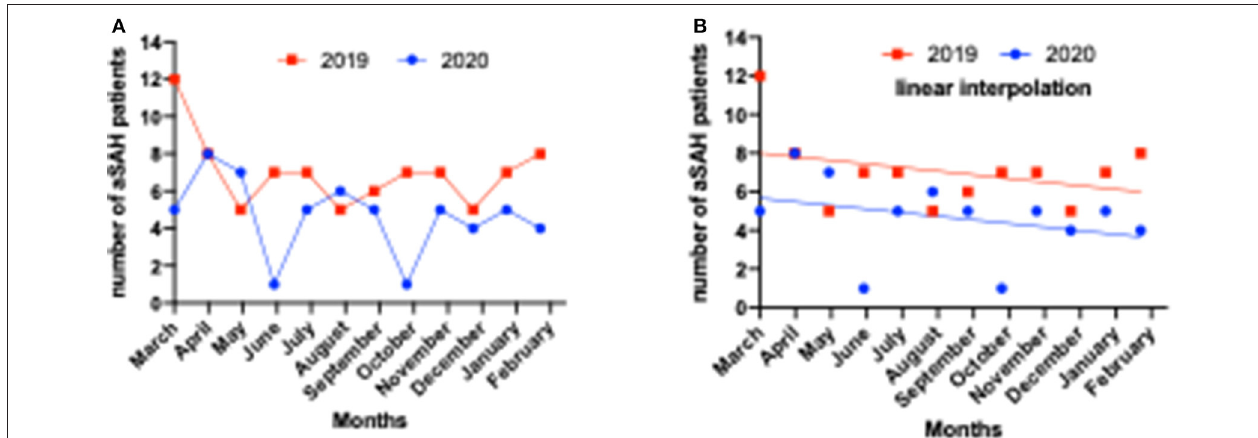
FIGURE 1 | Number of intensive care unit (ICU) – emergency admissions in patients with subarachnoid hemorrhage (SAH) during 1 year of COVID-19 pandemic (2020/2021) vs. the pre-pandemic year (2019/2020) in Frankfurt am Main, Germany. (A) Development of the number of patients presenting with aneurysmal subarachnoid hemorrhage per calendar month during COVID-19 pandemic (2020/2021) vs. the pre-pandemic year (2019/2020). (B) Incidence of patients admitted because of aneurysmal SAH (aSAH) during 1 year of COVID-19 pandemic (2020/2021) vs. the pre-pandemic year (2019/2020) without reaching a significant